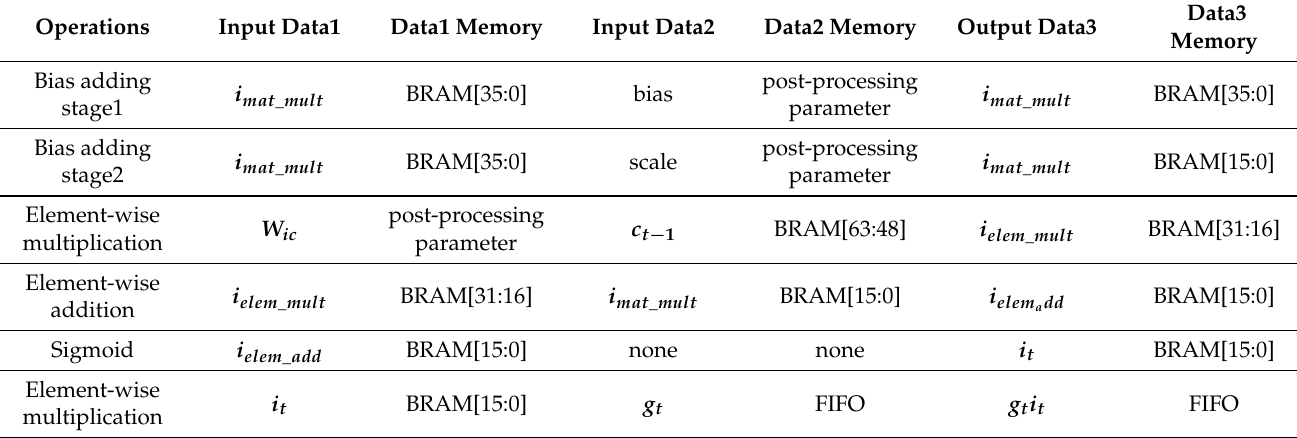
Table 4. Memory reuse